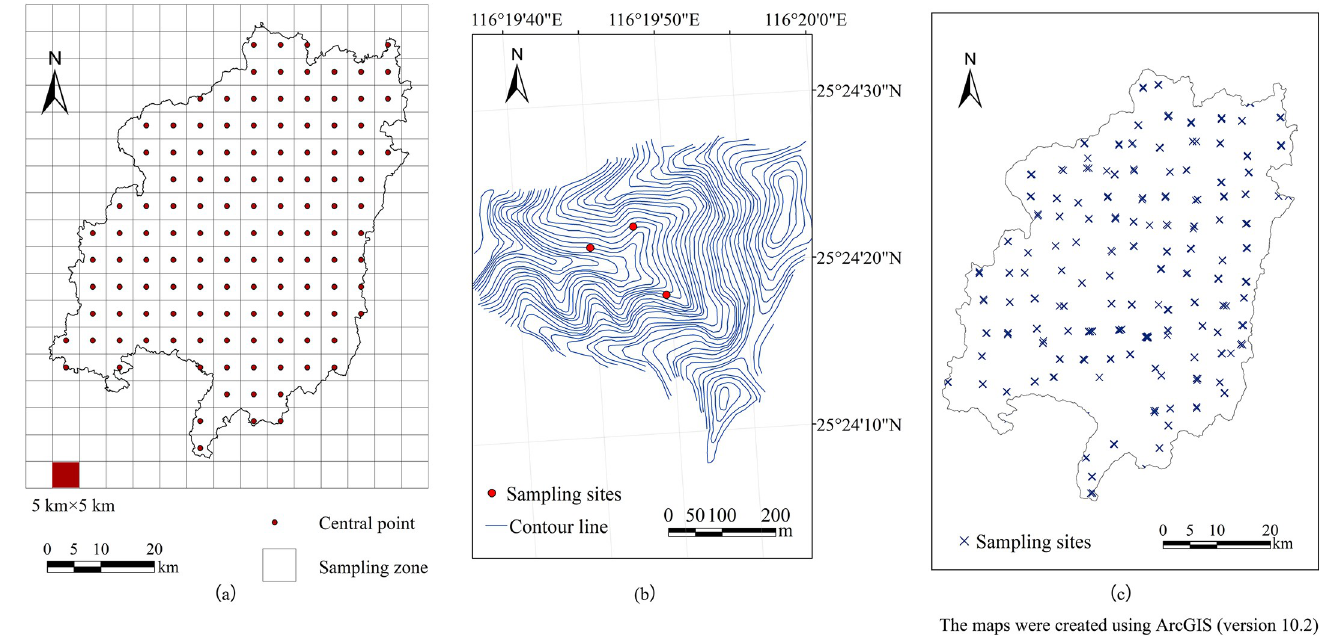
Fig 2. Sample design and distribution of sampling sites in Changting